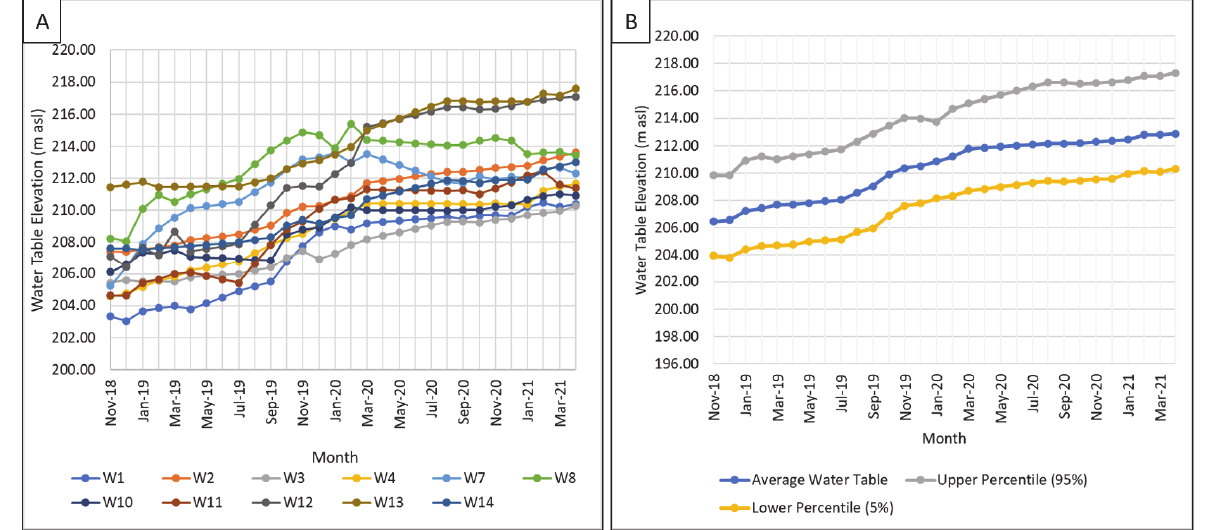
Figure 7. ( A ) Water table data from 11 wells in Hadat Ash ‐ Sham Farm Station; ( B ) The monthly average, upper percentile (95%), and lower percentile (5%) of water table data from 11 wells, Hadat Ash ‐ Sham Farm Station.